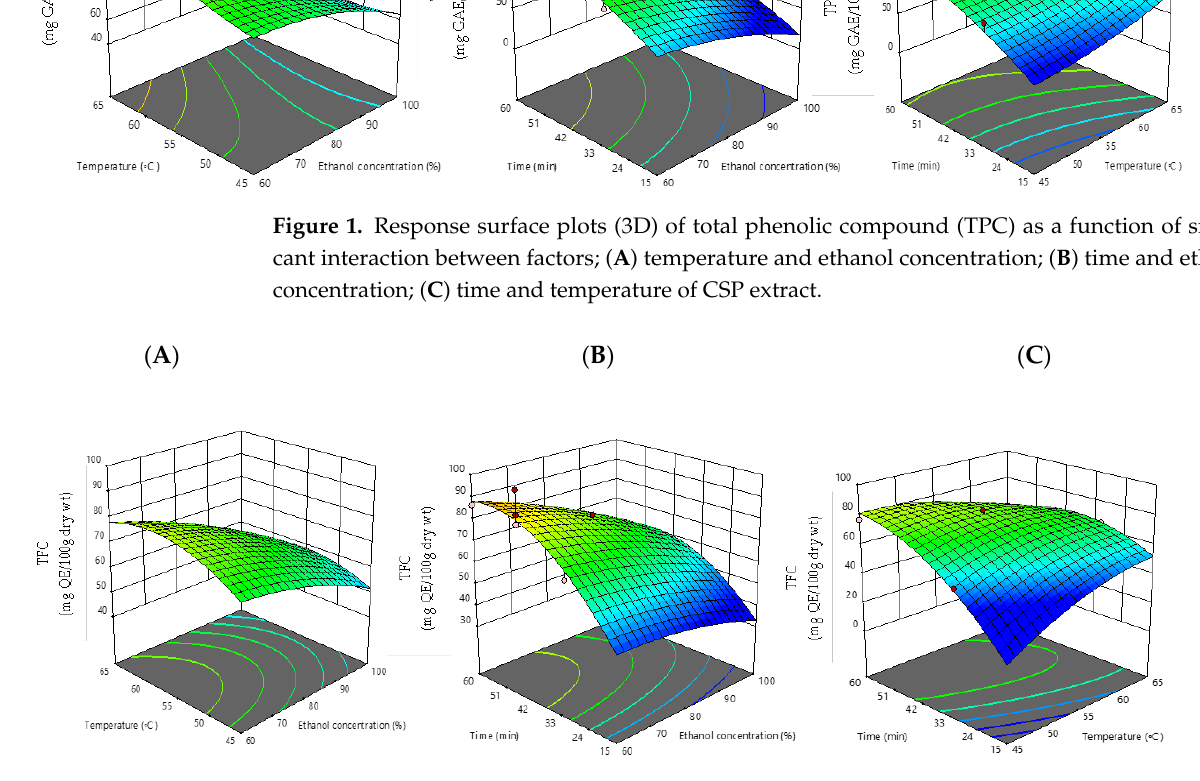
Figure 2. Response surface plots (3D) of total flavonoid content (TFC) as a function of significant interaction between factors;( A ) temperature and ethanol concentration; ( B ) time and ethanol concentration; ( C ) time and temperature of CSP extract.